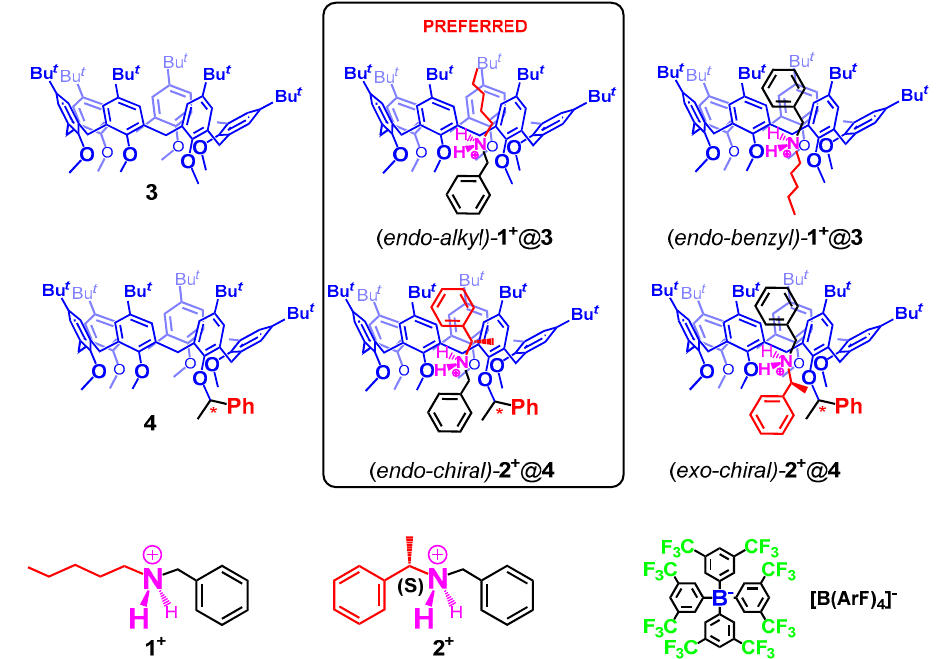
Figure 1. Chemical drawing of calix[6]-wheels 3 and 4 , dialkylammonium ammonium axles 1 + and 2 + used as barfate salts [B(Ar F ) 4 ] − , and their pseudorotaxane architectures.